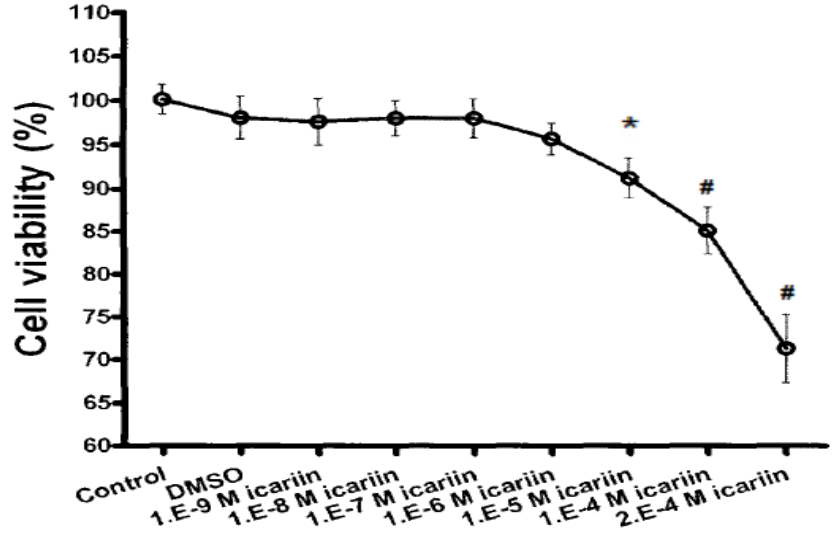
Figure 5. Proliferation of hBMSCs stimulated by icariin (n =